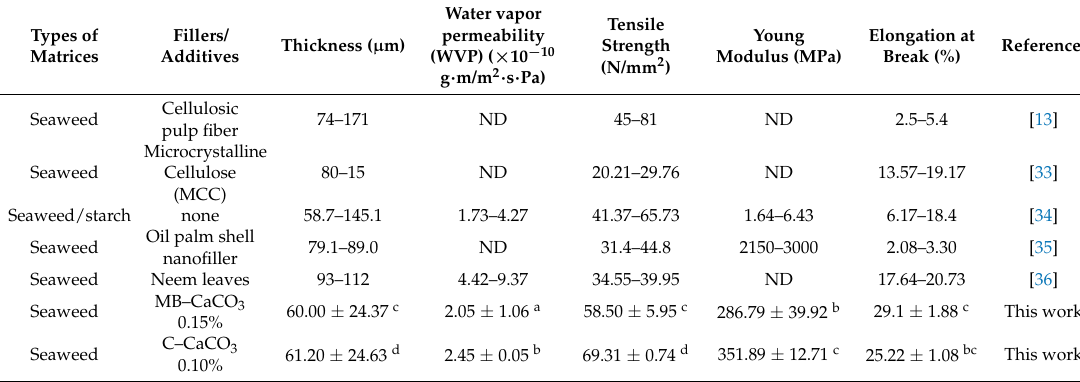
Table 2. Comparison of physical and mechanical properties of some seaweed-based films for packaging applications.